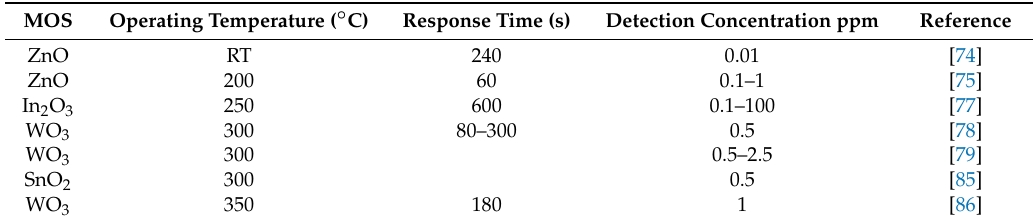
Table 4. Several metal–oxide–semiconductor (MOS) materials have been examined for NOx detection. MOS Operating Temperature ( ◦